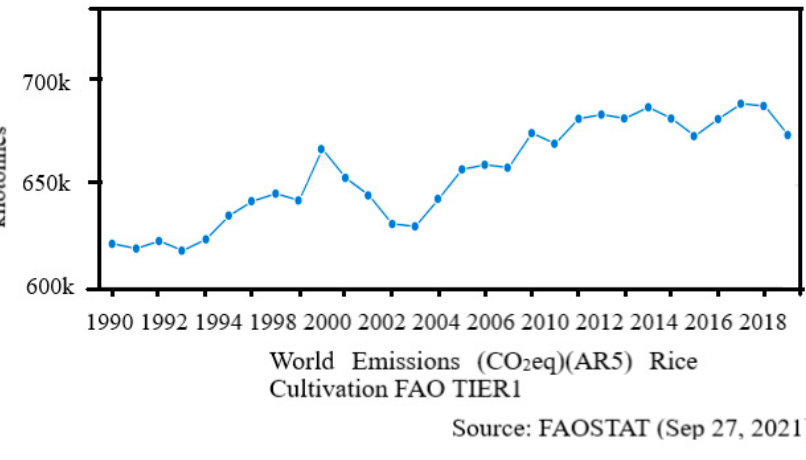
Figure 6. Total emissions from rice cultivation on a global scale (1990–2019) [162].